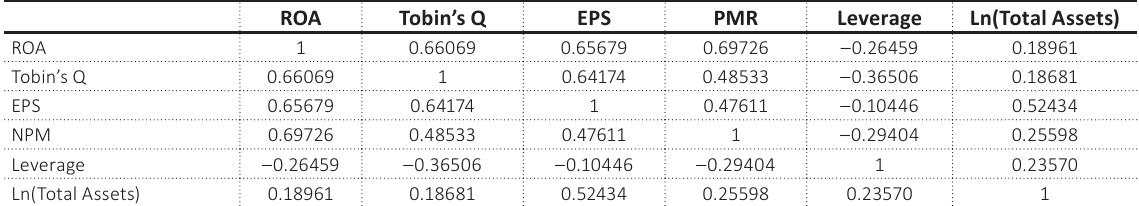
Table 3. Pearson’s correlation coefficient values for the relationships between the